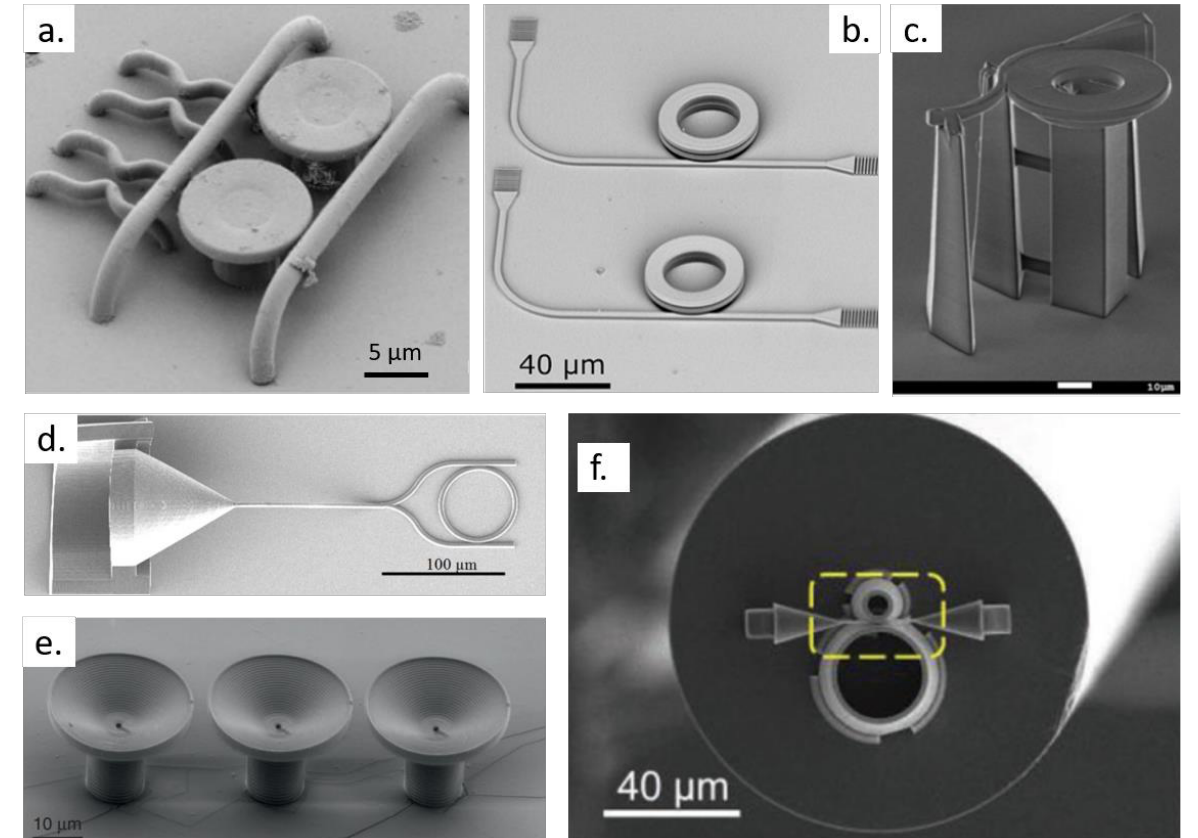
Figure 12. Polymeric microresonators fabricated by femtosecond laser writing via TPP. ( a ) microdisk resonators fabricated from a nanodiamond photoresist to enable quantum photonics applications, ( b ) two vertically-coupled microring resonators incorporated with liquid crystal networks and an azo dye to afford light-driven tunability, ( c ) microring resonator inside a glass microfluidic chip for biosensing, and ( d ) integrated microring resonator used for ultrasound detection. ( e ) Goblet-shaped microresonators fabricated on a PDMS elastomer substrate for coupling tunability, and ( f ) microring resonators fabricated on the facet of a multicore optical fiber for vapor sensing. Figure 12a Reproduced with permission [135]. Licensed under a Creative Commons Attribution 4.0 International license. ( b ) Reproduced with permission [131]. Copyright © 2018, American Chemical Society. ( c ) Reproduced with permission [132]. Copyright © 21019, The Royal Society of